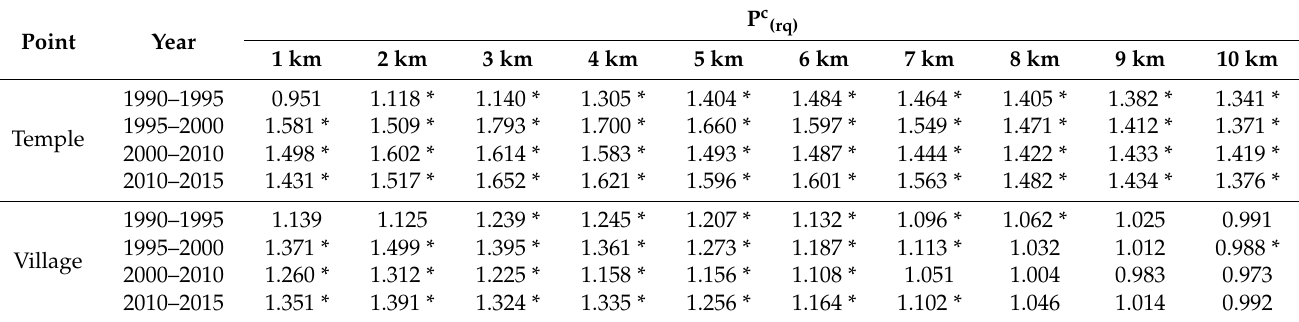
2015. Table 3. The P c (rq) value of conversion from grassland to forestland in 1–10 km